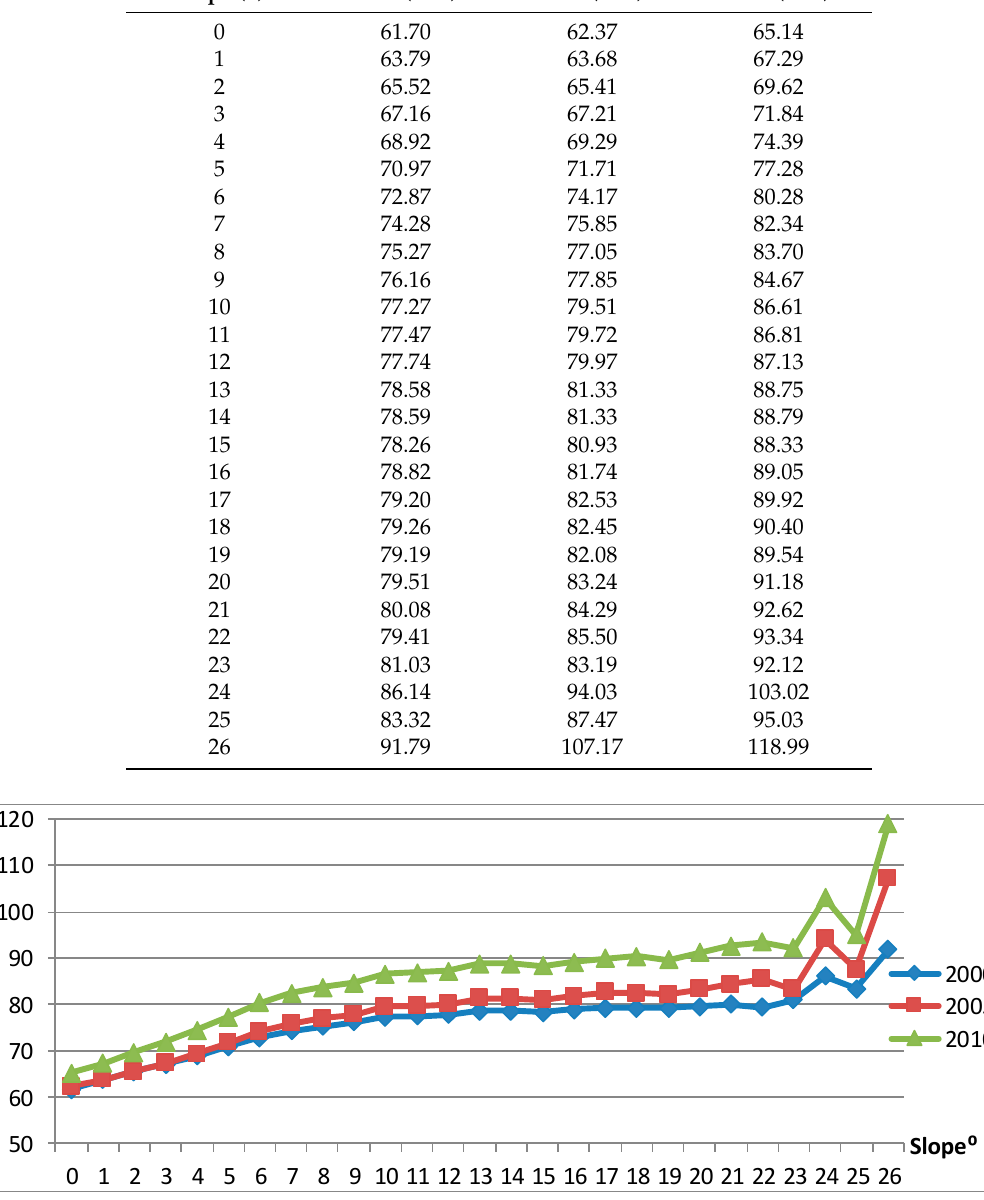
Table 2. Carbon density of areas with different slopes in the Loess Plateau.